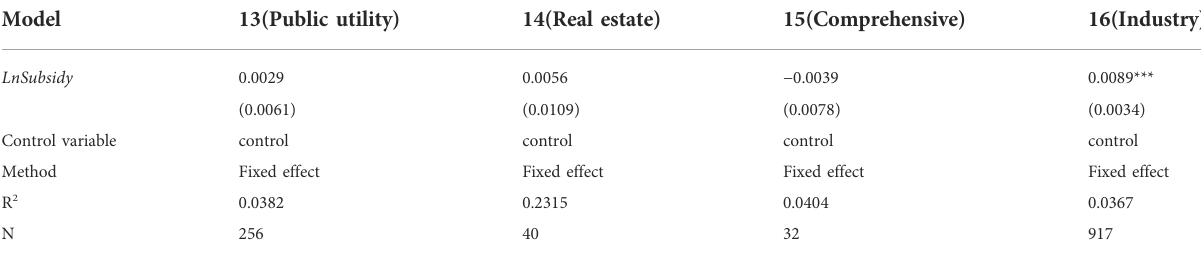
TABLE 7 Industry heterogeneity